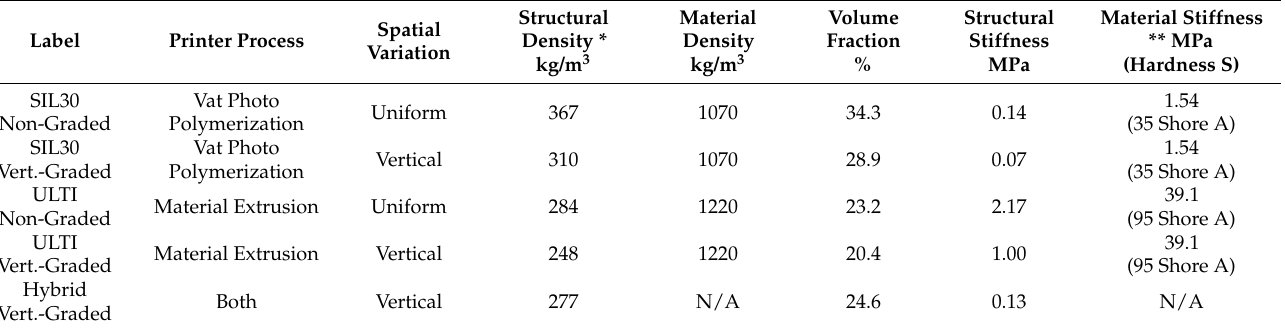
Table 1. Metamaterial quasi-static characteristics.